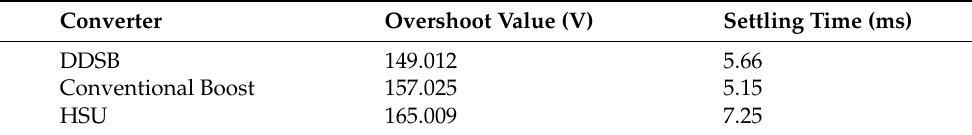
Table 5. Steady-state time